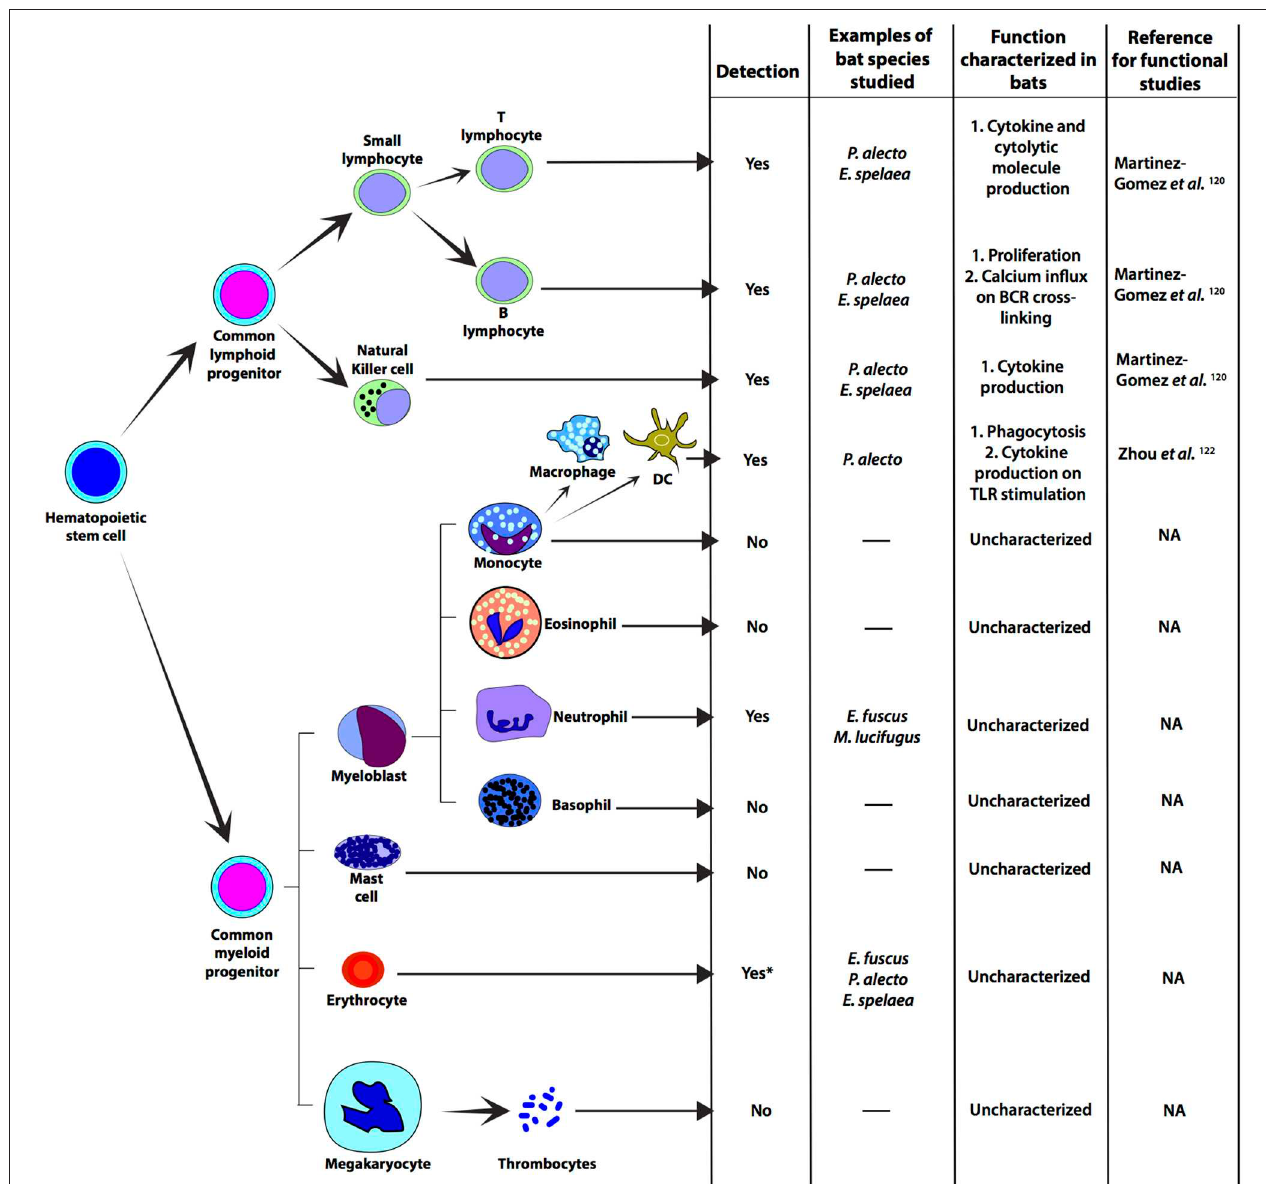
FIGURE 3 | Immune relevant cells that have been detected in representative bat species. Progenitor cells and cellular differentiation have not been studied in bats, but there are some studies on myeloid and lymphoid cells. Most studies on bat immune-relevant cells have been carried out on cells from fruit bats. Functional characterization of bat T and B cells have been carried out by detecting cytokines that are secreted by these cells on stimulation (120, 121). NK cells from P. alecto and E. spalaea have been detected by flow-cytometry (121). Macrophages from P. alecto have been detected and cultured in vitro by using P. alecto -specific reagents. Functional characterization of P. alecto macrophages have been carried out by stimulating them with TLR3 ligand [poly(I:C)] and TLR7/8 ligand (CL097) (122). Neutrophils have been detected in E. fuscus and M. lucifugus by differential staining (49, 123). Thrombocytes have not been characterized, but the ability of bats to heal their wounds has been studied (124). *Depletion of red blood cells (erythrocytes; RBCs) from bat samples have been reported, but RBCs from bats have not been functionally characterized. NA, not applicable; DC, monocyte derived dendritic cell; TLR, Toll-like receptor.